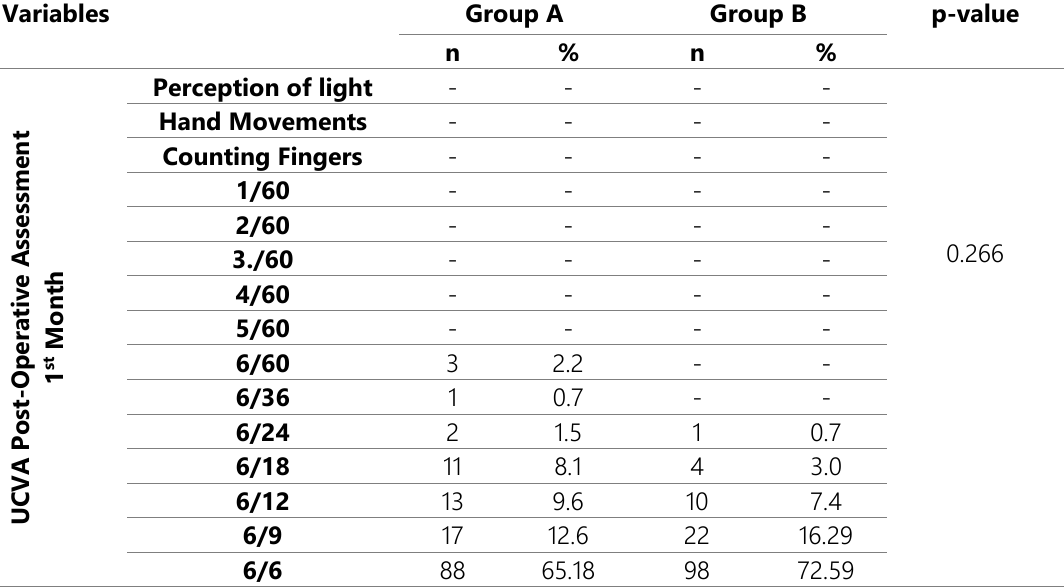
Table 4: Uncorrected visual acuity according to Snellen Eye chart at 1 st month postoperative